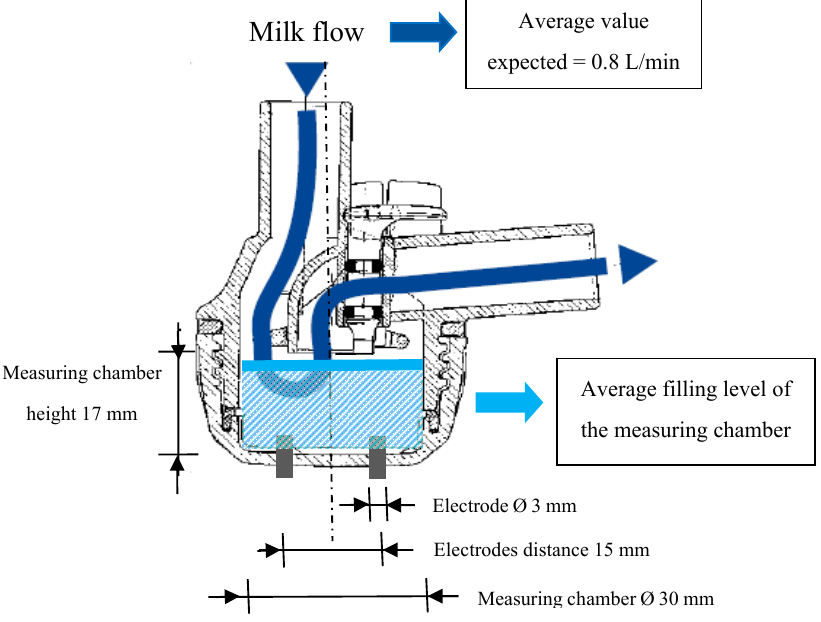
Figure 1. Dimensions of the EC sensor head placed at the base of each individual teatcup.